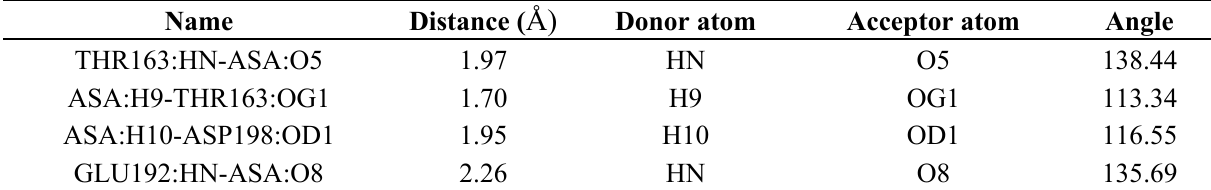
Table 3. The hydrogen bonds between ASA and